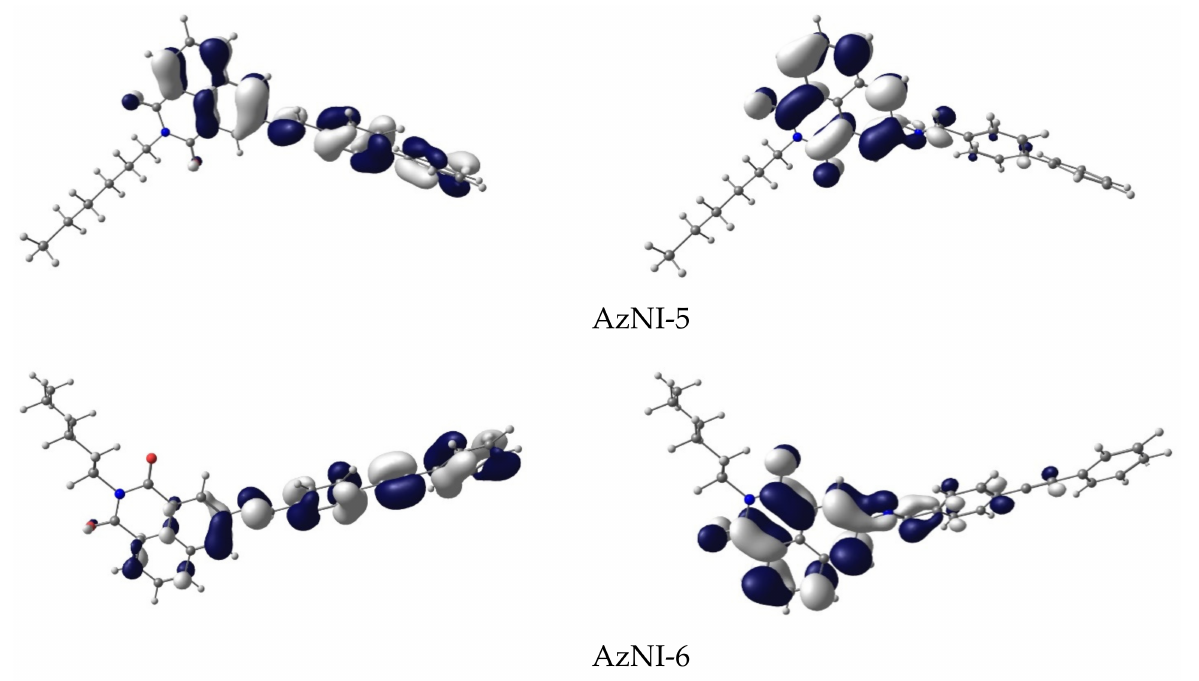
Figure 4. Contours of HOMO and LUMO energy levels of studied